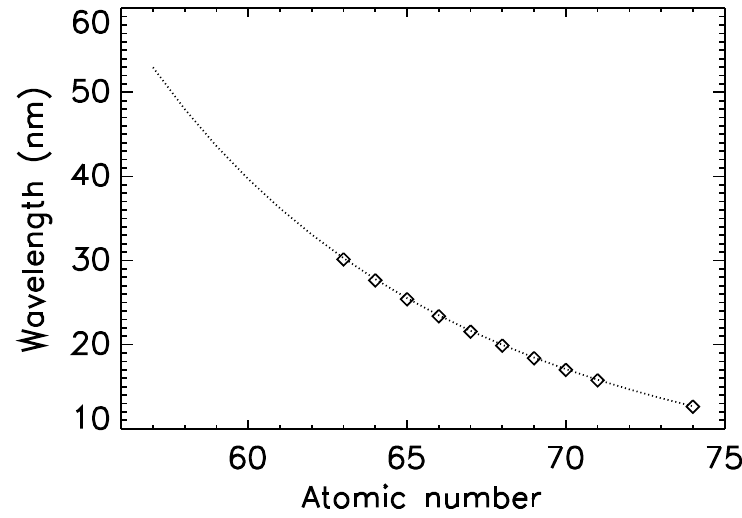
Figure 3. Z dependence of the wavelength of the magnetic dipole (M1) transition from (4p + ) 3/2 to the ground state (line c in Figure 1b) of Ga-like ions. The wavelengths measured in LHD plasmas are shown by diamonds, while the calculated wavelength is drawn by a dotted